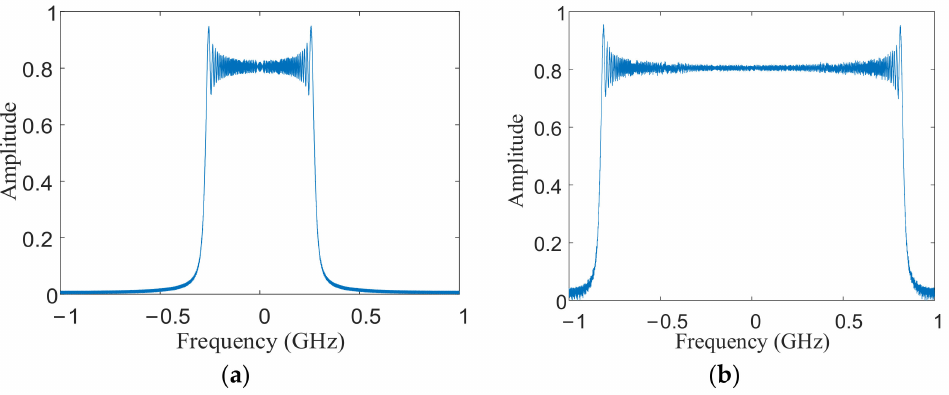
Figure 5. Bandwidth synthesis of single point target. ( a ) sub-band bandwidth; ( b ) synthesized bandwidth.